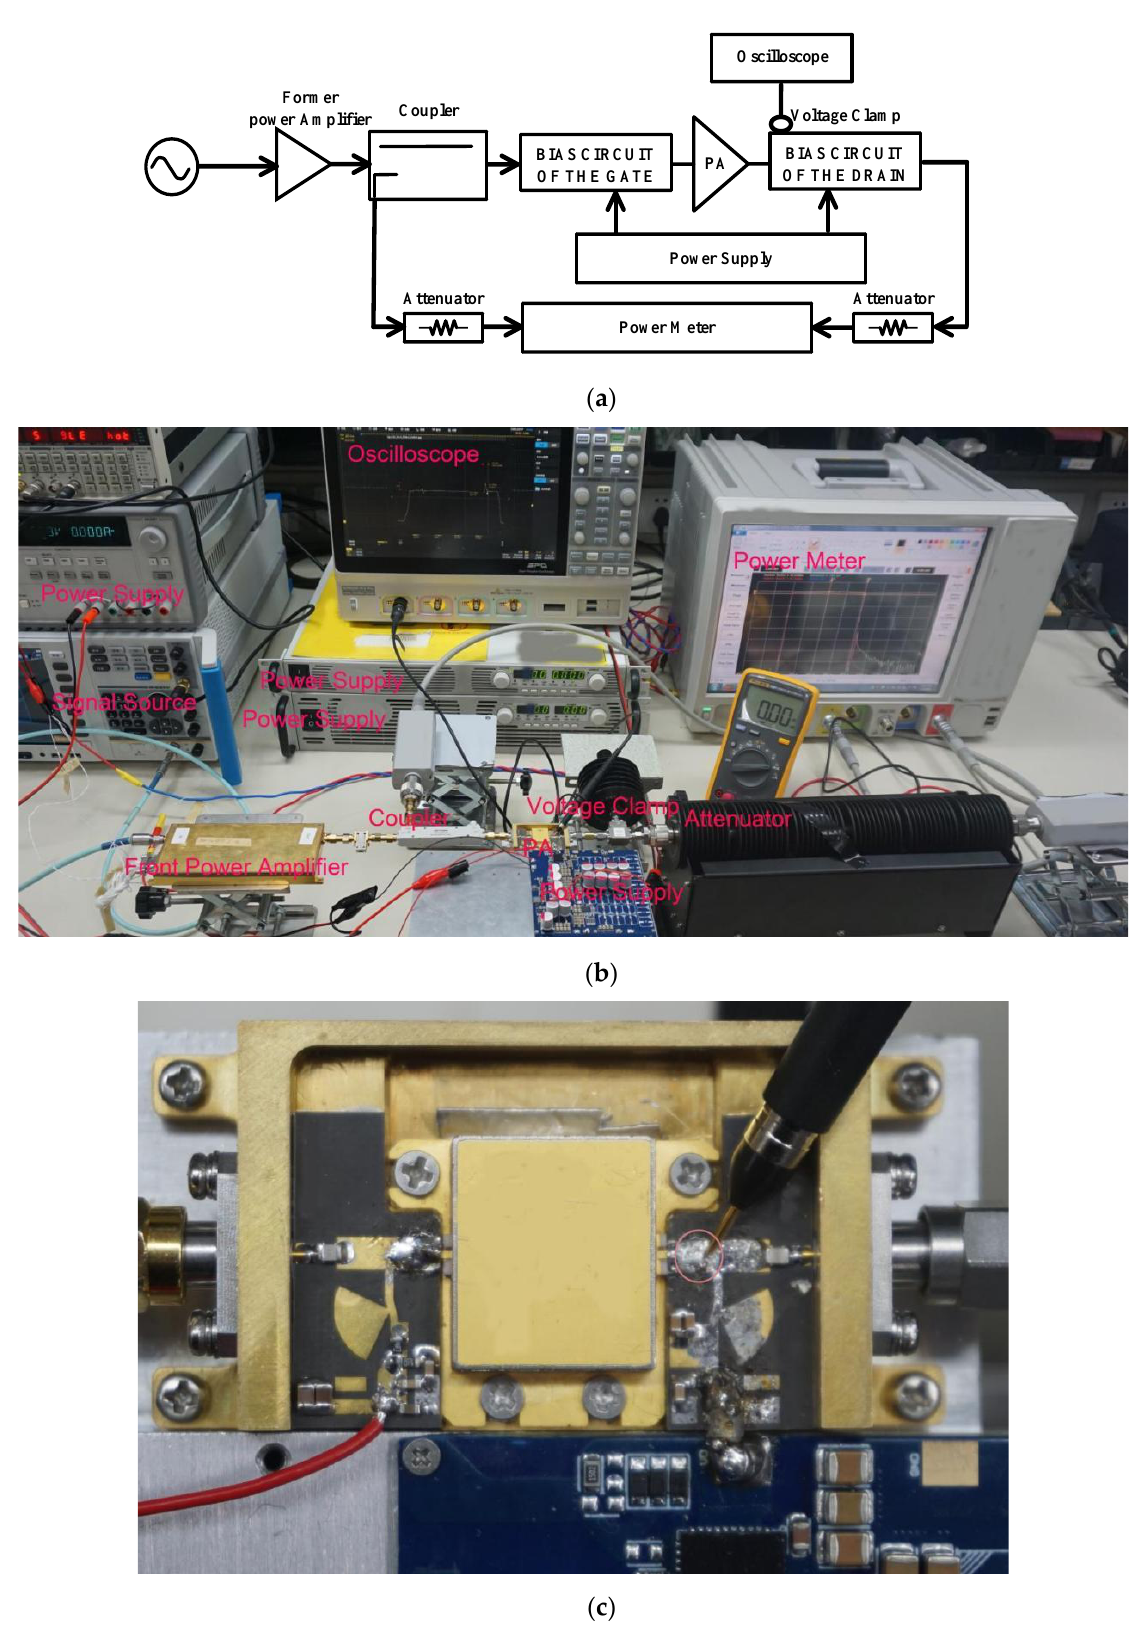
Figure 14. ( a ) The schematic diagram of the measurement system. ( b ) The physical diagram of the measurement system. ( c ) The voltage probe measurement location. Both the traditional and proposed power-amplifier systems operate in class AB mode. The gate voltage of traditional and proposed power-amplifier systems is fixed at